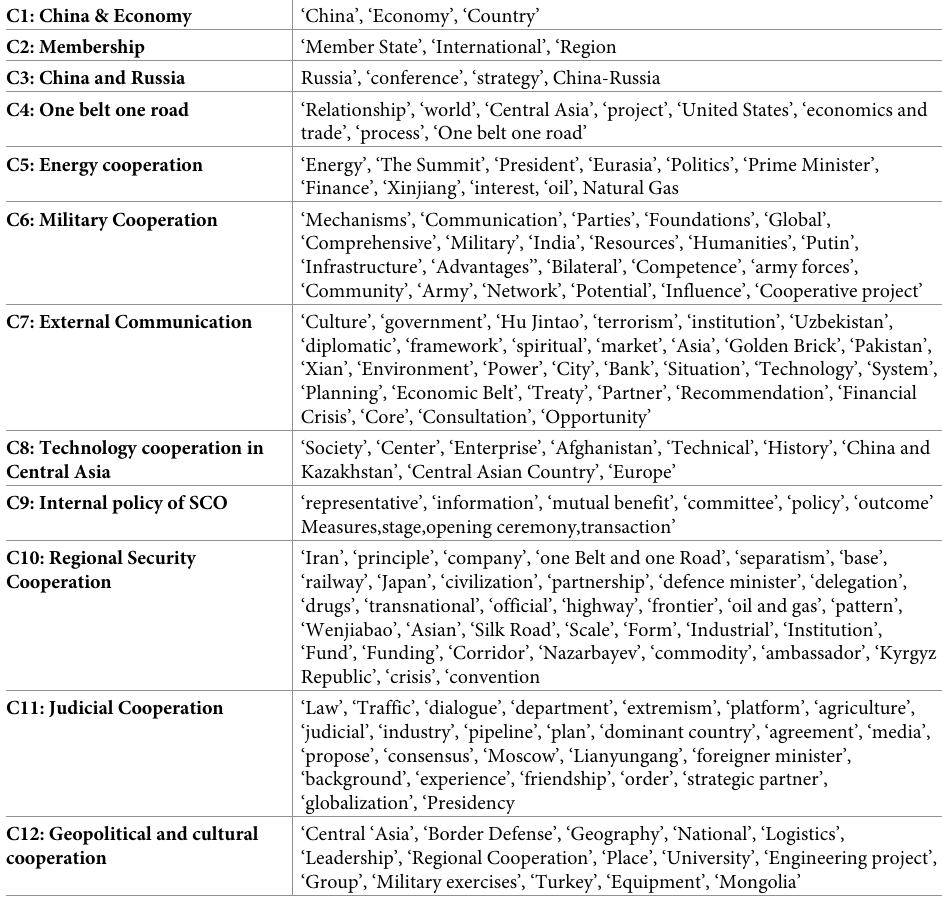
Table 3. The result of cluster analysis from 2001 to 2019.